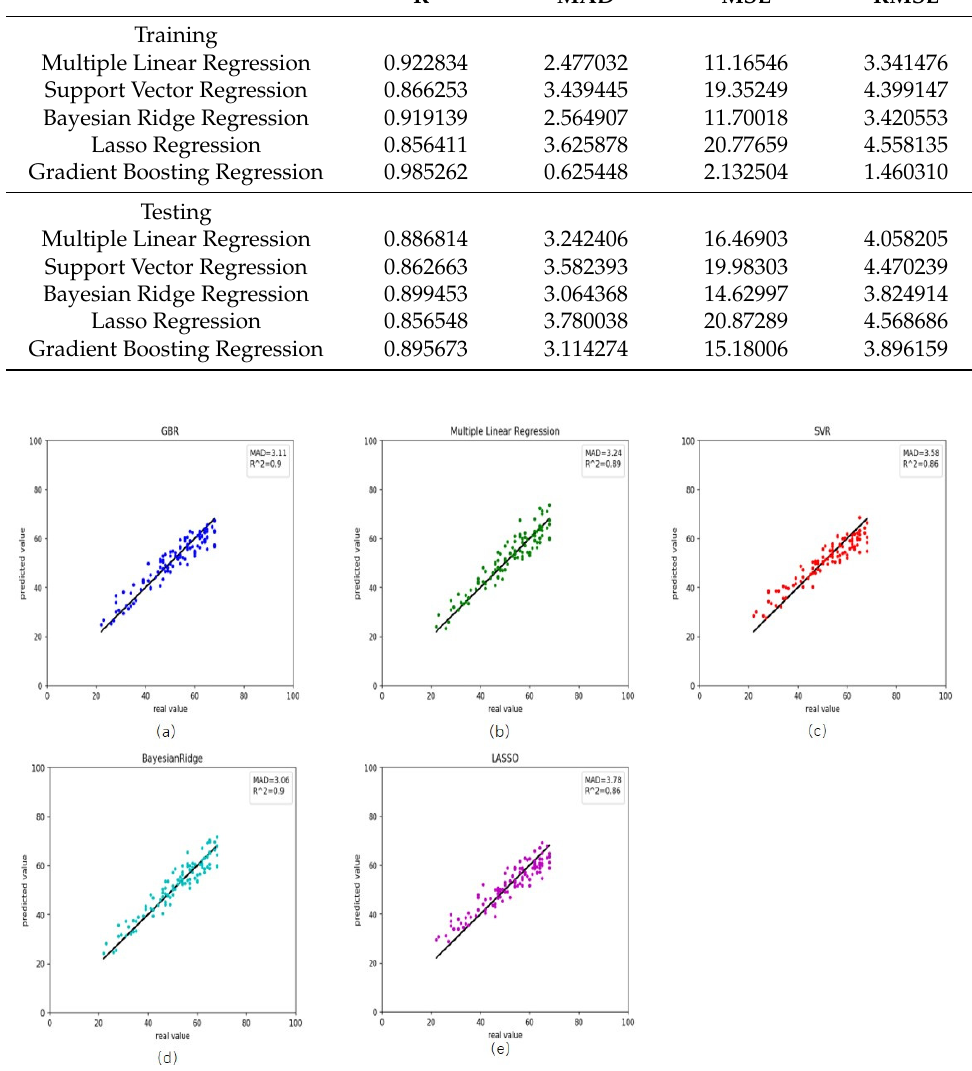
Figure 5. Comparison results between the actual age and predicted age by five different models on the testing rheumatoid arthritis data. ( a ) gradient boosting regression, ( b ) multiple linear regression, ( c ) support vector regression, ( d ) Bayesian ridge regression and ( e ) lasso regression.